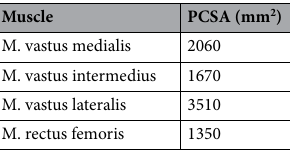
Table 2. Muscles included in the model with relative PCSAs.